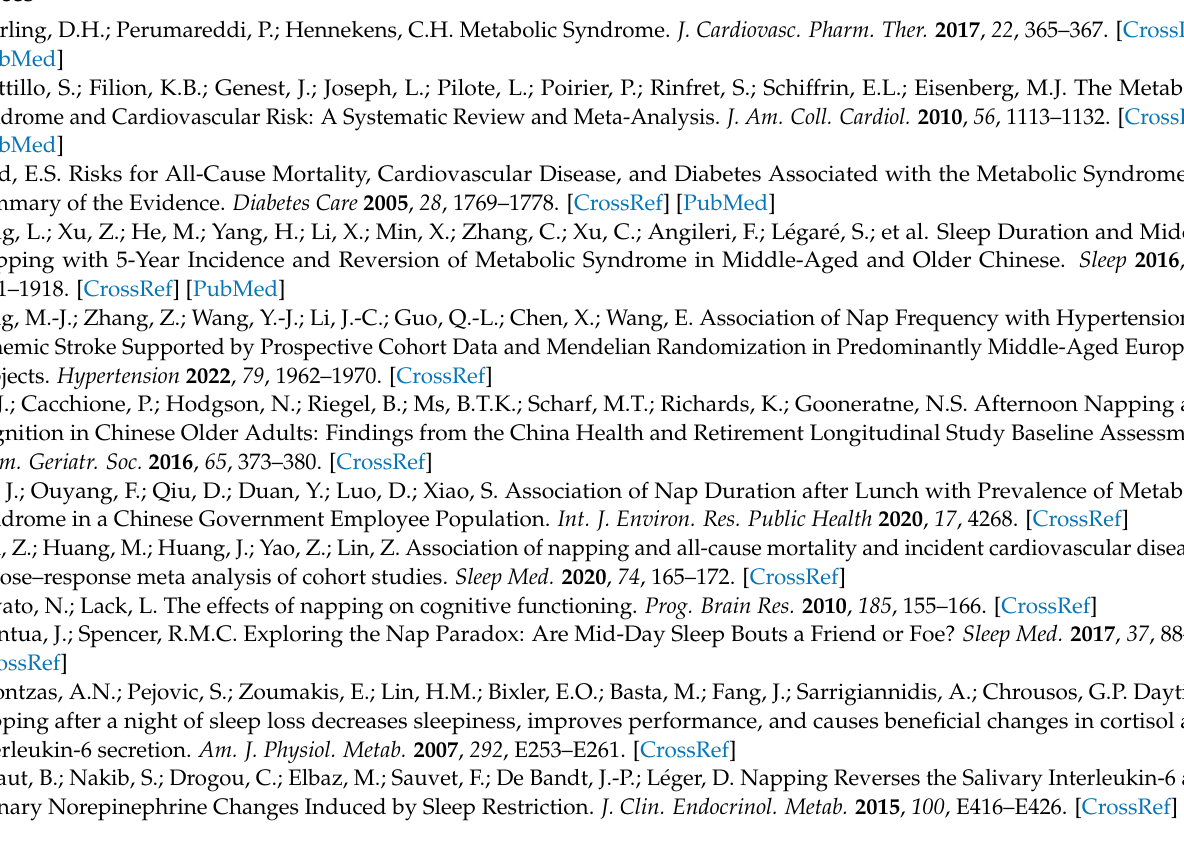
Table S12: Longitudinal associations of baseline metabolic syndrome status and its components with follow-up daytime napping duration after using the secondary outcomes; Table S13: Longitudinal associations of baseline metabolic syndrome status and its components with follow-up daytime napping duration in subgroup analyses; Table S14: Cross-lagged regression coefficient of daytime napping duration with MetS severity